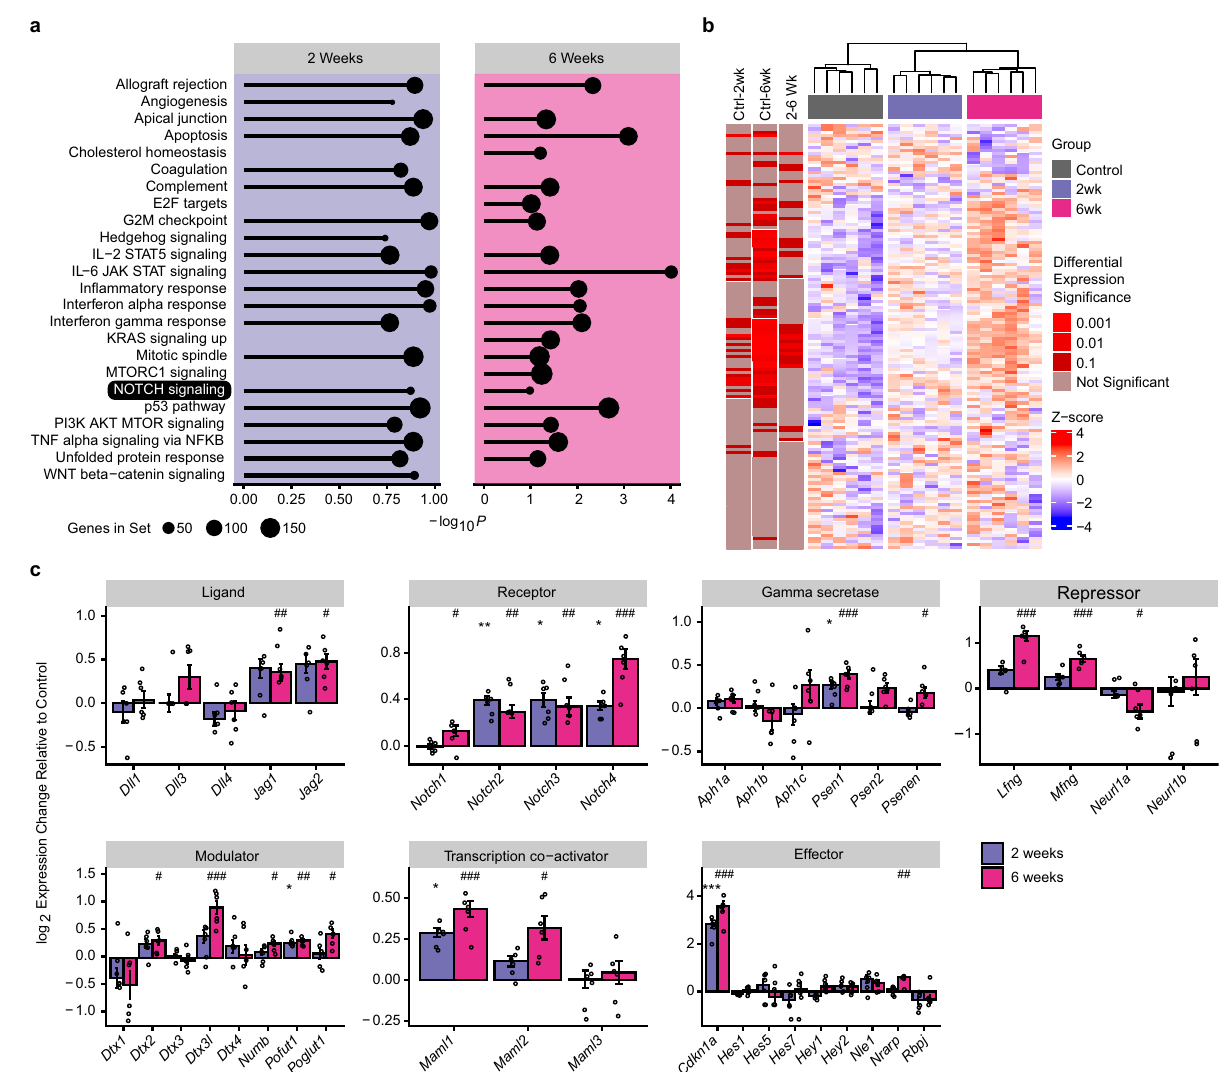
Fig. 5 Post-IR states exhibit distinct transcriptional signatures and activation of the Notch signaling pathway. a Top 20 transcriptionally over- represented hallmark pathways at 2 and 6 weeks post-IR. The Notch signaling pathway is present at both timepoints, and Notch pathway-associated genes Cdkn1a , Jag1 , Jag2 , and Notch2 were drivers of enrichment in other over-represented pathways. b Heatmap of Notch GO term genes. Samples group by hierarchical clustering of Notch GO gene expression. c Cardiac-related Notch pathway members grouped by function. Bar graphs represent log 2 -fold change at 2 weeks or 6 weeks post-IR relative to sham control state and error bars represent standard error ( n = 6 biologically independent samples per treatment group, *indicates comparisons of 2 weeks post-IR versus control, # indicates comparisons of 6 weeks post-IR versus control, */ # P < 0.10, **/ ## P < 0.01, ***/ ### P < 0.001). Jag1 ## P = 0.0049; Jag2 # P = 0.03; Notch1 # P = 0.076; Notch2 ** P = 0.0066, ## P = 0.0012; Notch3 * P = 0.014, ## P = 0.0019; Notch4 * P = 0.015, ### P = 7.2E − 6; Psen1 * P = 0.051, ### P = 0.00078; Psenen # P = 0.024; Lfng ### P = 1.0E − 6; Mfng ### P =